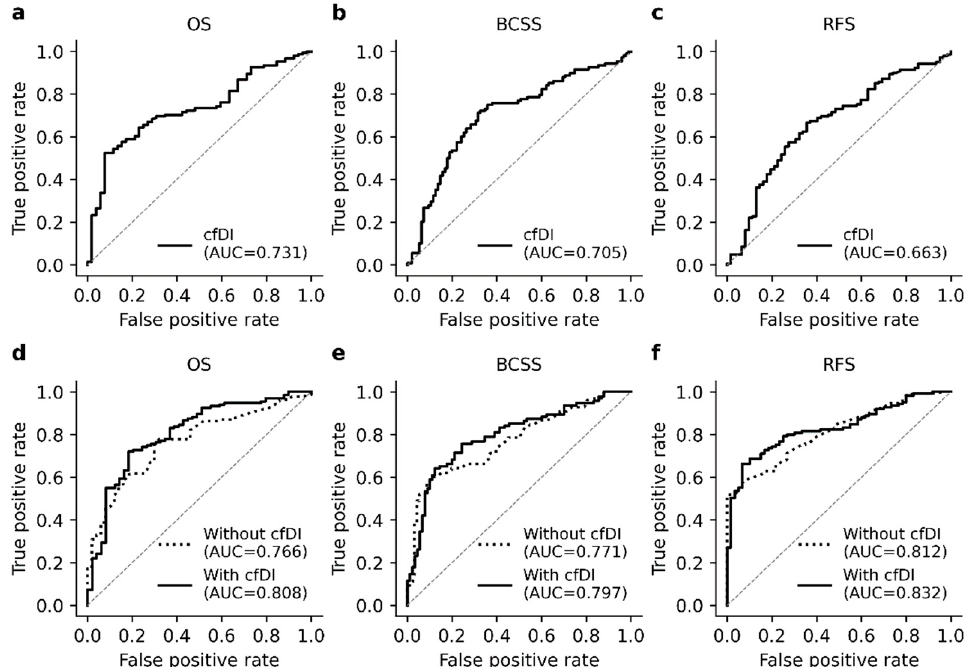
Figure 5. Performance of the univariate and multivariate logistic regression models with cfDI. The top row ( a – c ) represents the ROC curves derived from the univariate logistic analyses with cfDI as a predictor. The ROC curves illustrate that cfDI predicts OS and BCSS with an acceptable accuracy but is less accurate biomarker for BC recurrence. The bottom row ( d – f ) represents the performance of the multivariate logistic regression model with and without cfDI and illustrates how including the cfDI in the model improves the general model performance.